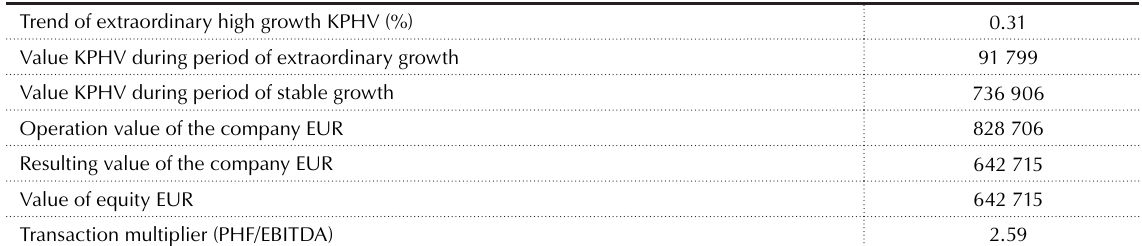
Table 4. Value of the company – model of extraordinary growth followed by stable growth Trend of extraordinary high growth KPHV